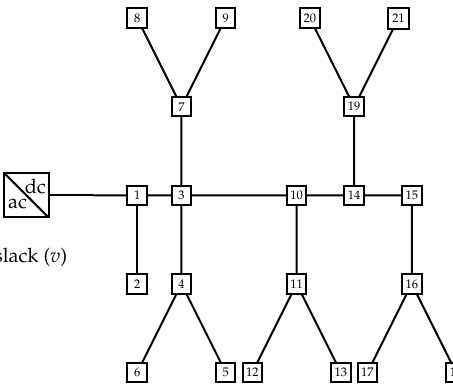
Figure 1. Grid configuration of the 21-bus system.